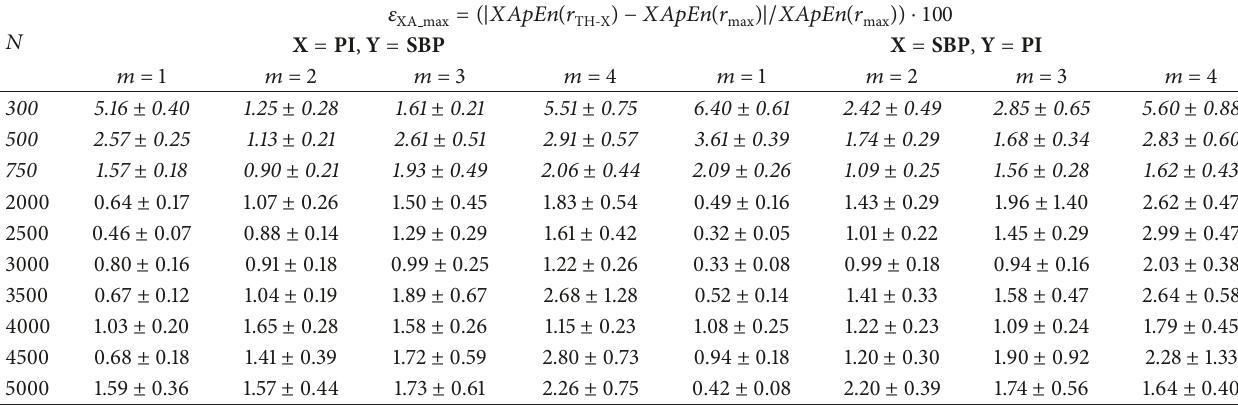
) with respect to XApEn ( 𝑟 max ) in real signals [ % ] TH-X